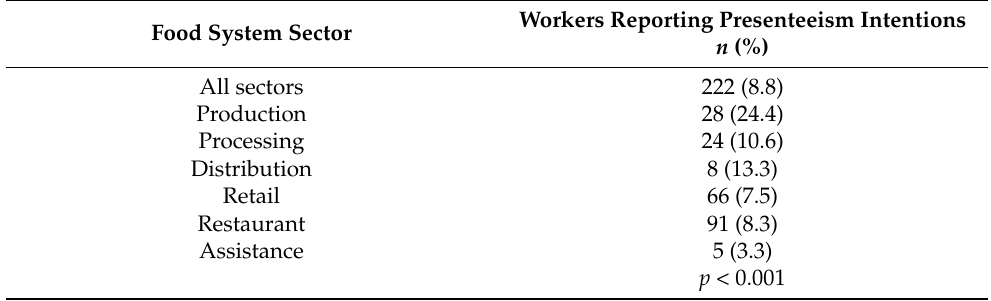
Table 2. Prevalence of presenteeism intentions in a national sample of U.S. food system workers during early COVID-19, by food system sector ( N = 2353).